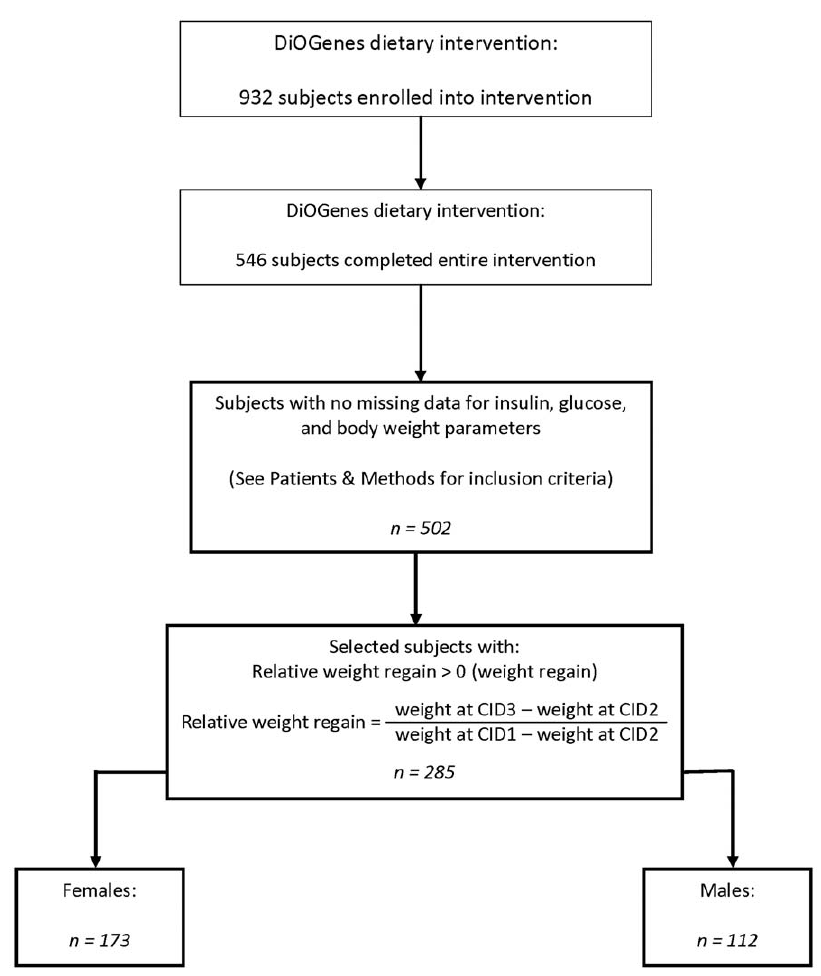
Figure 1. Flowchart for subject selection from the DiOGenes cohort.